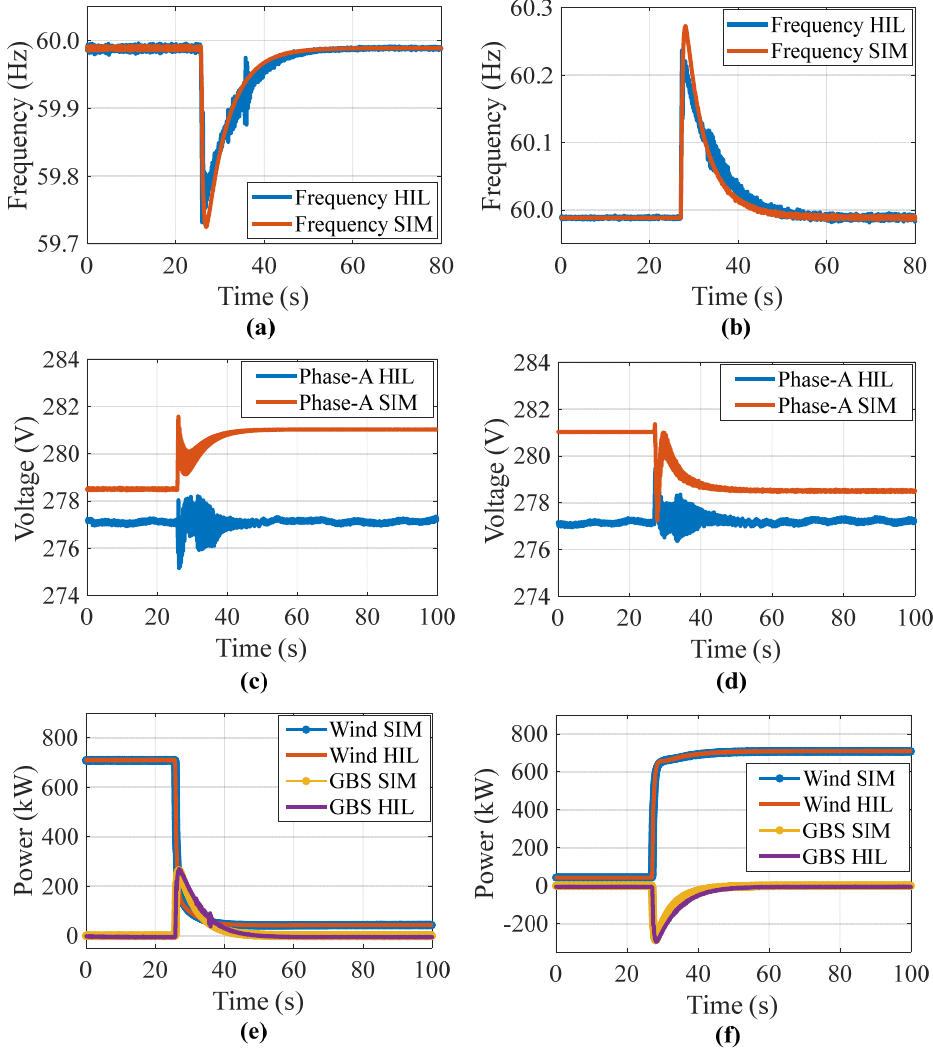
Figure 18. Comparison between Simulation and Experimental Results. ( a ) Frequency for loss of wind. ( b ) Frequency for increase in wind. ( c ) Voltage for loss of wind. ( d ) Voltage for increase in wind. ( e ) Active power for loss of wind. ( f ) Active power for increase in Wind.